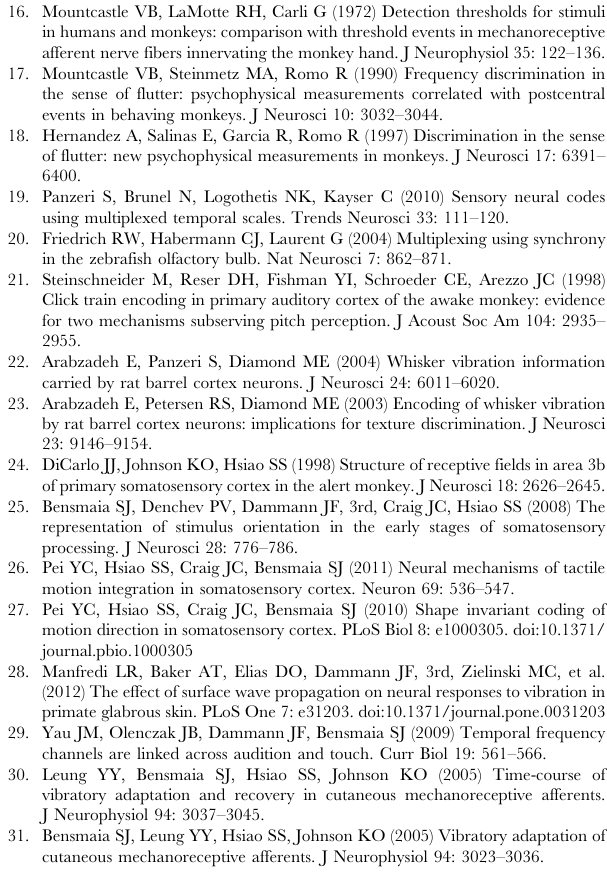
Figure S5 Neural responses to diharmonic sweeps. (A) Spectrograms of two diharmonic sweep stimuli. (B) Spectrogram of the response elicited in an individual neuron. Figure S6 Multiplexing of stimulus information for noise stimuli. (A) Mean mutual information between instanta- neous amplitude and firing rates (blue) or spectral peak (orange), computed from the responses of PL neurons, and neurons in areas 3b, 1, and 2. (B) Mean mutual information between spectral content and firing rates (blue) or spectral peak (orange), computed from the responses of PL neurons, and neurons in areas 3b, 1, and 2. Mirroring the results with sinusoids, mutual information between amplitude and firing rates was higher than between amplitude and spectral composition ( F (1,146) =34.7, p , 0.01); mutual information between peak frequency of the stimulus and peak frequency of the response was higher than between peak frequency of the stimulus and response rate ( F (1,146) = 33.1, p , 0.01). While information about the instantaneous stimulus amplitude is low in the spectral response across all populations, PL and area 3b neurons convey information in their time-varying firing rates. Conversely, information about time-varying frequency composition is mostly conveyed in the spectral responses of neurons. Note some information about frequency in firing rates stems from the fact that the noise stimuli were biased towards lower frequencies (where firing rates do convey information) and that frequency and amplitude are not independent in our noise data on short time-scales.